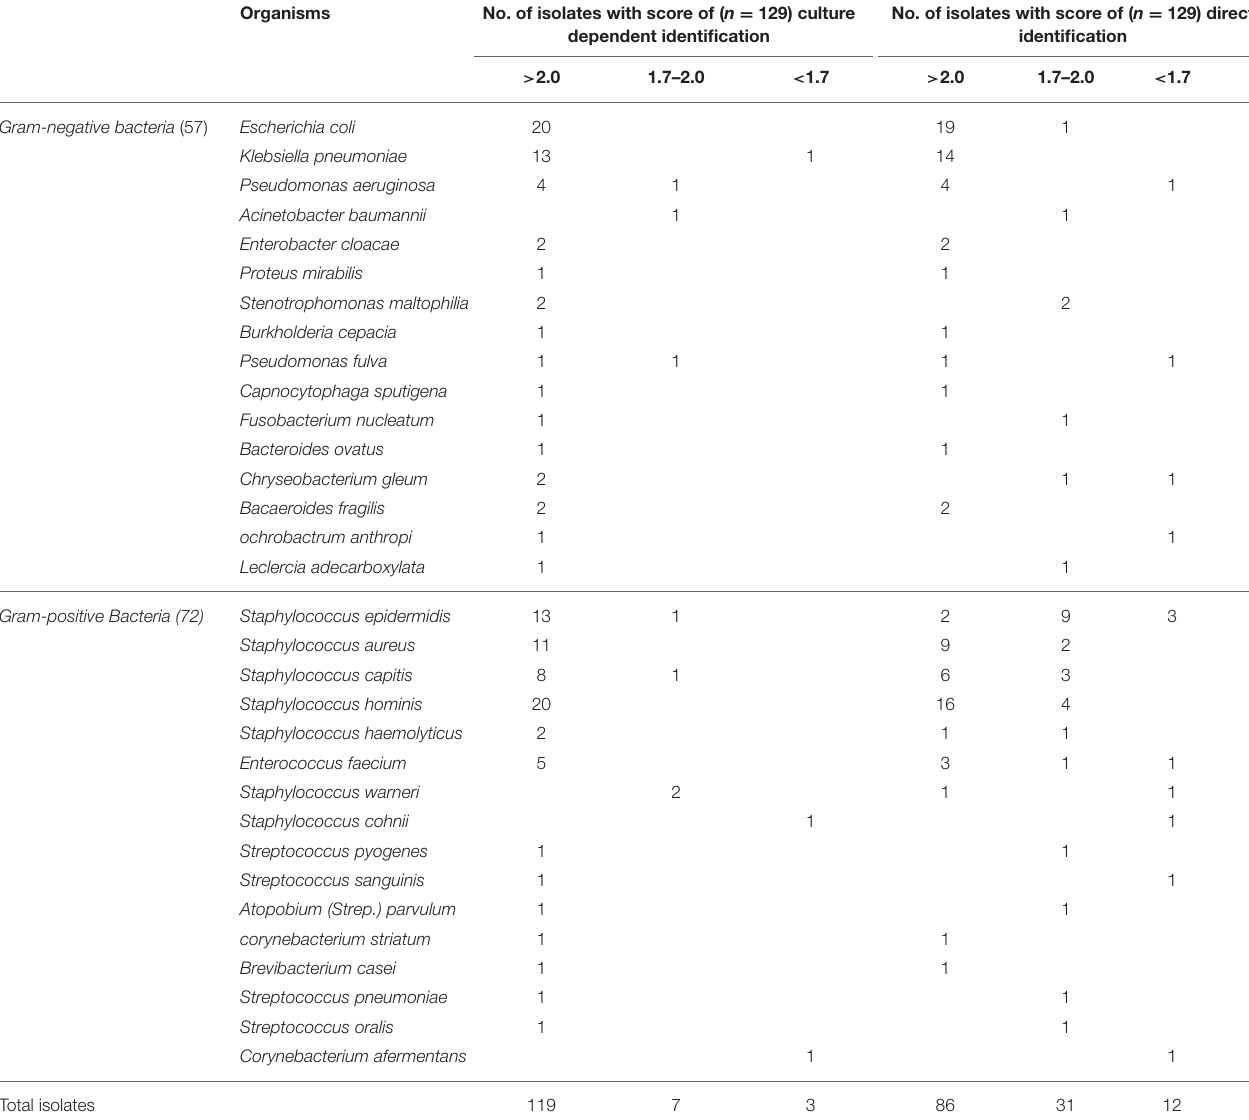
TABLE 1 | MS Identifiaction results by coventional culture-dependent method and our developed method ( n =